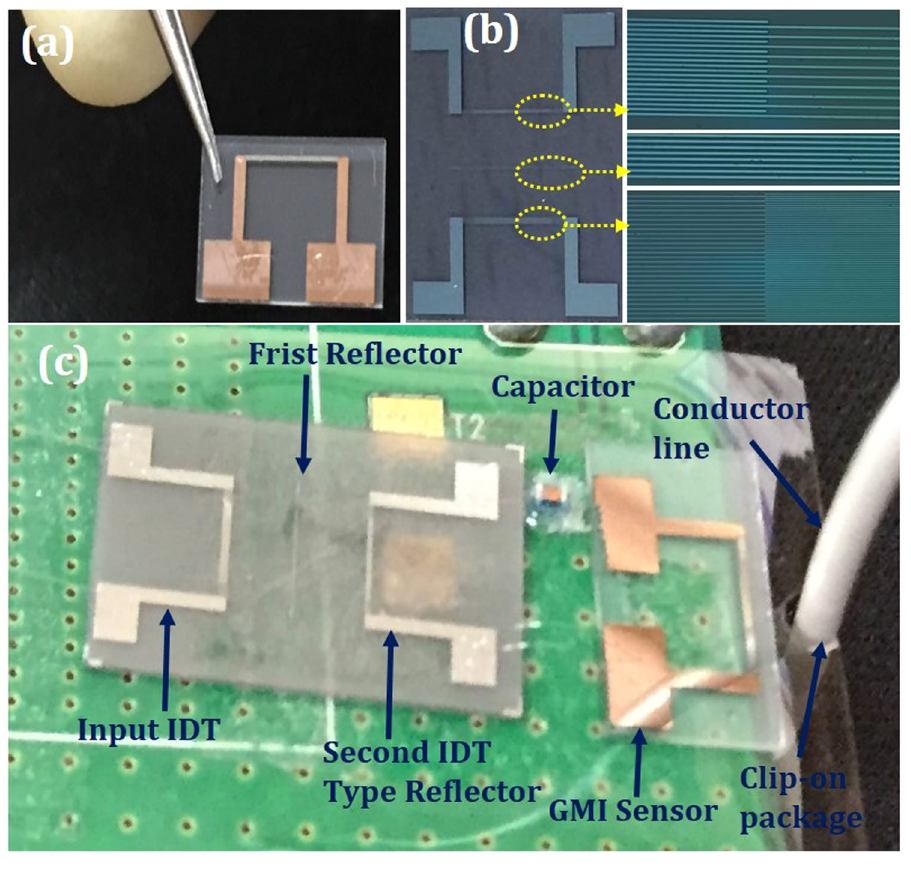
Figure 3. ( a ) View of the fabricated GMI sensor, ( b ) Overall and magnified views of the one port SAW reflective delay line, ( c ) Assembled units of all the devcies on clip-on packaging platform for wireless current